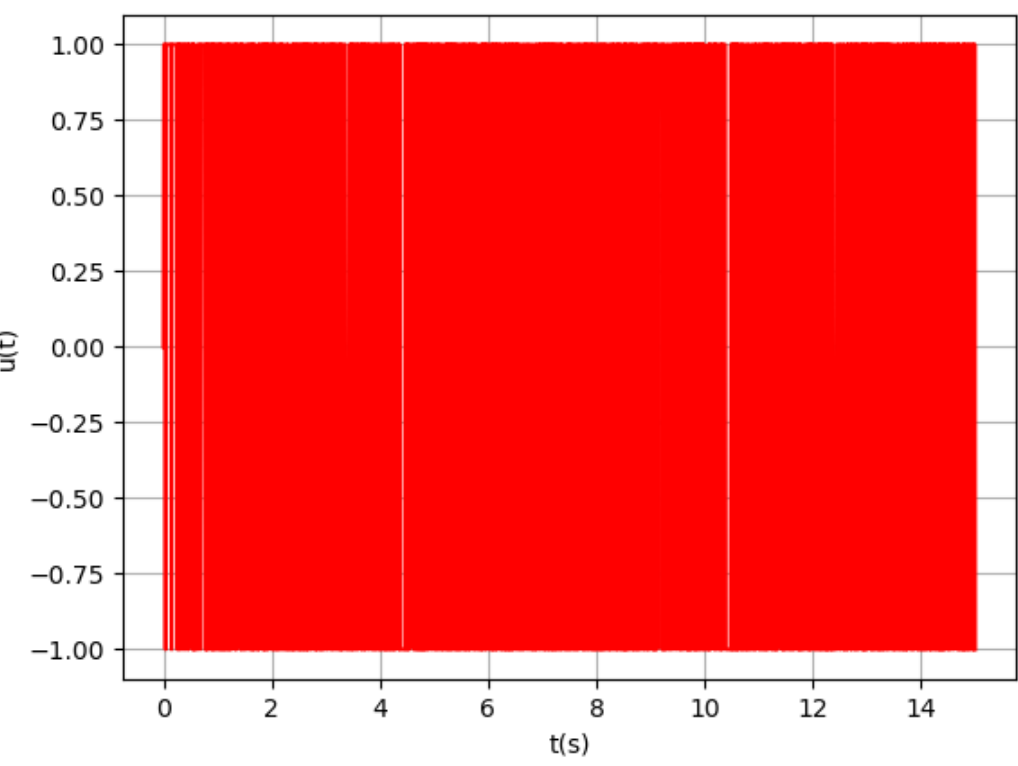
Figure 7. Resultant control signal: sensor noisy